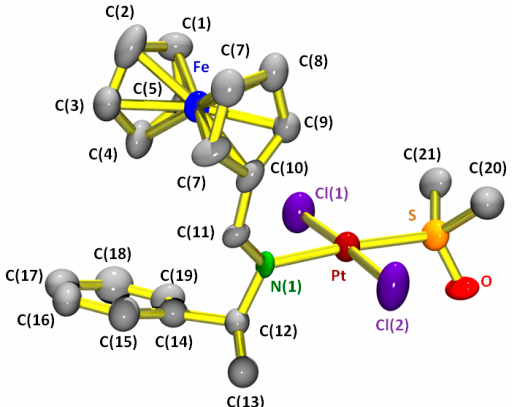
Figure 4. Molecular structure and atom labelling scheme for trans -( S c ) - [Pt{( η 5 -C 5 H 5